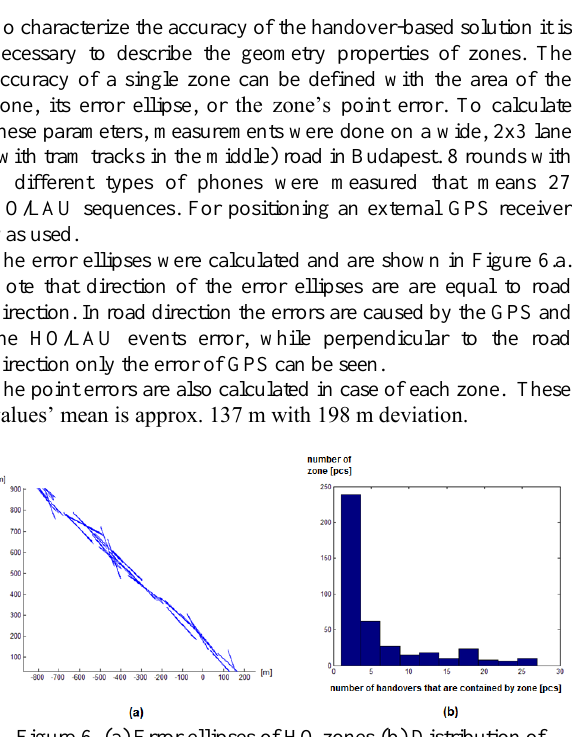
Figure 4. Short example and crossing road problem PFA is a 5-tuple ⟨ ⟩ , where alphabet will be all observed LACs and Cell-IDs in measuring phase, is the set of